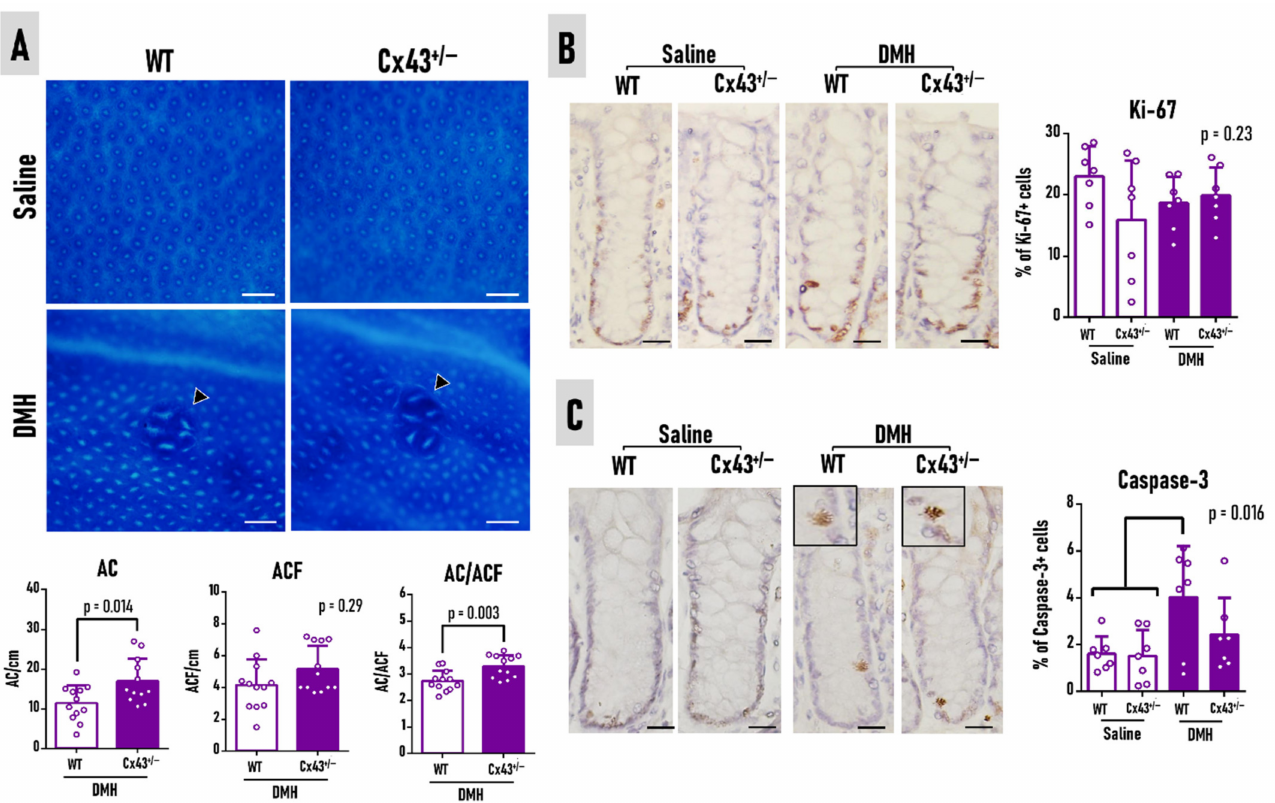
Figure 4. The implications of connexin 43 heterologous deletion (Cx43 +/ − ) on ( A ) the aberrant crypt foci (ACF) burden, ( B ) epithelial crypt proliferation (Ki-67), and ( C ) apoptosis (caspase-3) during 1,2-dimethylhydrazine (DMH)-induced colon carcinogenesis in C57BL/6J mice at week 37. ( A ) Representative photomicrographs of a whole mount of colon specimens stained with methylene blue (scale bar: 100 µ m) depicting the absence (noninitiated) or the occurrence of ACF (DMH- initiated mouse) (arrowheads) and colon length, ACF, AC, and AC multiplicity (AC/ACF) data in both genotypes. ( B ) Representative microscopic overview (scale bar: 20 µ m) and semiquantitative analysis of Ki-67 and cleaved caspase-3 (details) immunostaining in the colonocytes of normal- appearing crypts in both genotypes. WT: wild-type. n = 7 (immunohistochemistry) or 12 (ACF data) mice/group/genotype. Data were presented as mean + standard deviation and data points. Data were analyzed by the one-way ANOVA and post hoc Tukey test (proliferation and apoptosis) or the Student’s t -test (ACF data) ( p <